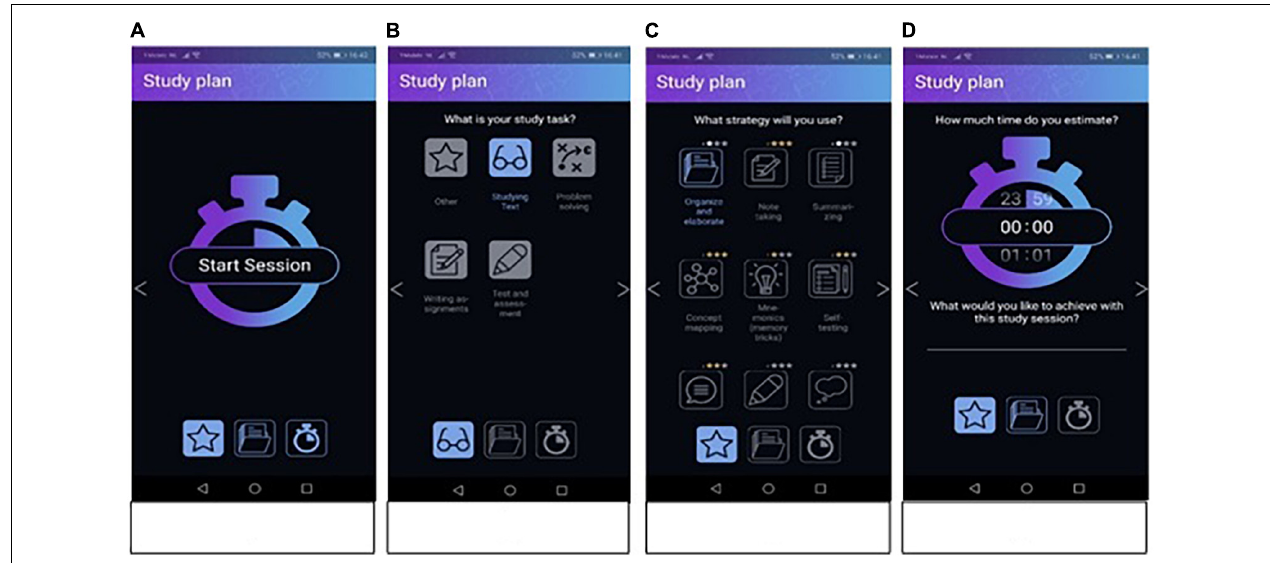
FIGURE 1 | Screenshots from the forethought phase, panel (A) shows the first “study plan” screen to start a session, panel (B) shows the second “study plan” screen at which students choose the type of task, panel (C) shows the third “study plan” screen at which students choose a strategy. Panel (D) shows the fourth “study plan” screen at which students can set the time and fill out their